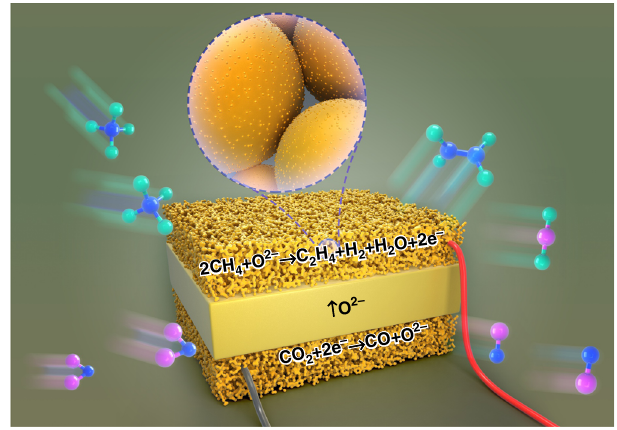
Fig. 1 Electrochemical oxidation of CH 4 to chemicals. Here the CO 2 is converted to CO in the cathode while CH 4 is converted to chemicals, such as C 2 H 4 in the anode through a simultaneous process in a solid oxide